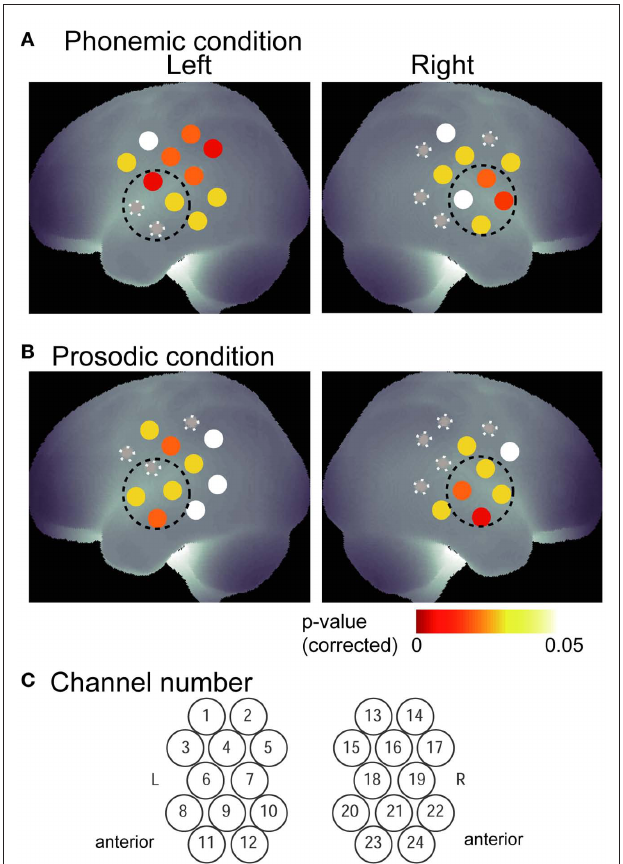
FIguRe 4 | Activation amplitude indicated by p -values for phonemic (A) and prosodic (B) conditions. Channel location of 12 channels for each hemisphere was estimated based on the virtual spatial registration (Tsuzuki et al., 2007). p -Values were corrected for multiple comparisons. Channels which did not reach 0.05 with a correction were indicated with a gray circle with white rays. Area shown with dashed line indicates vicinity of auditory area defined as ROI in this study. Channel numbers are indicated for both hemisphere